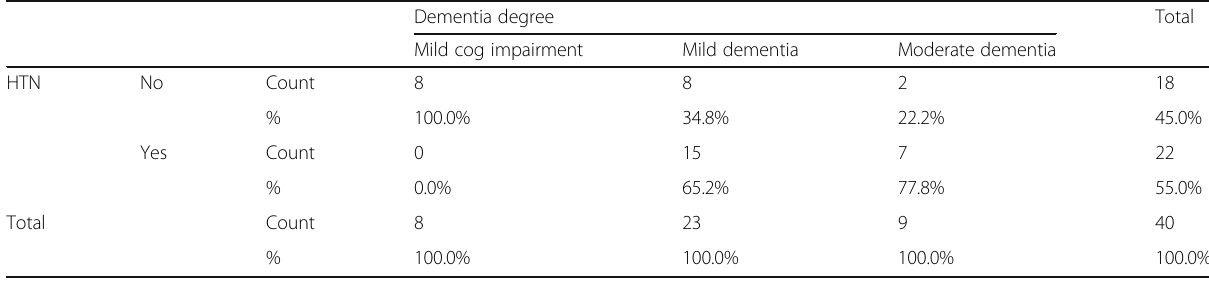
Table 8 Distribution of the degree of dementia according to the history of hypertension Dementia degree